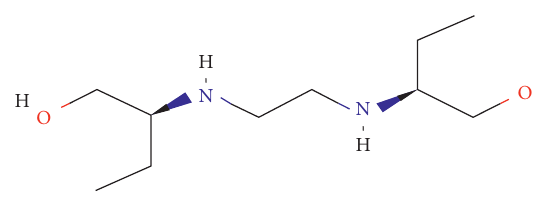
Figure 1: Chemical structure of